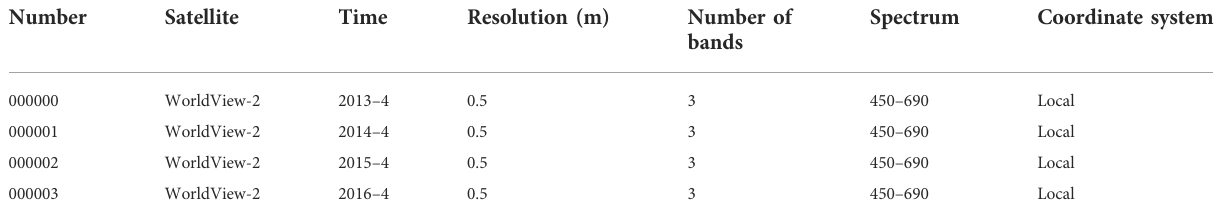
FIGURE 2 The study area map.